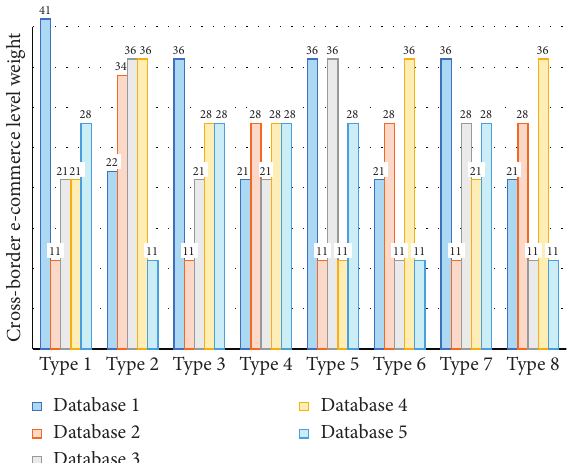
Figure 2: Distribution of crossborder e-commerce level weights.